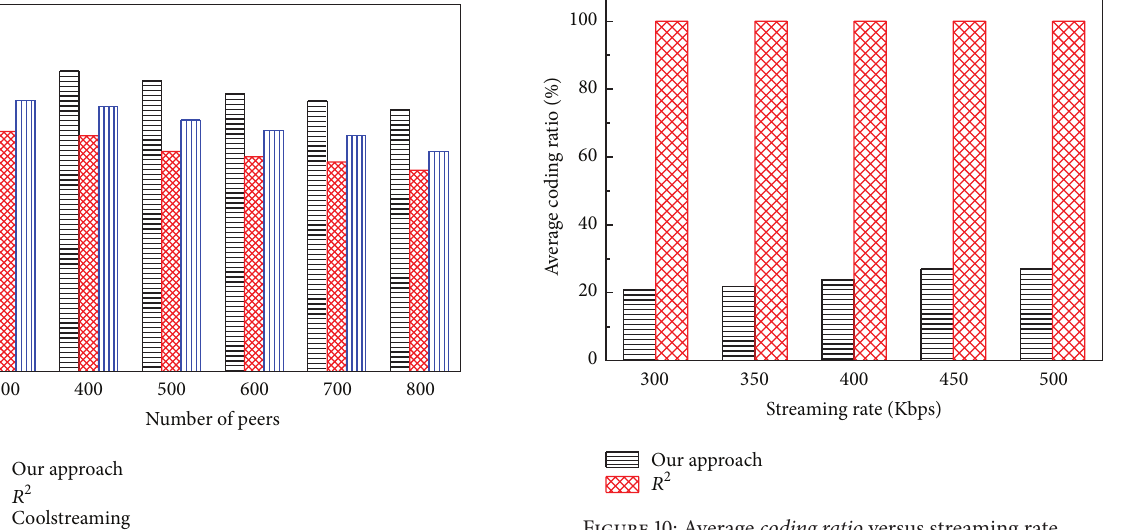
Figure 10: Average coding ratio versus streaming